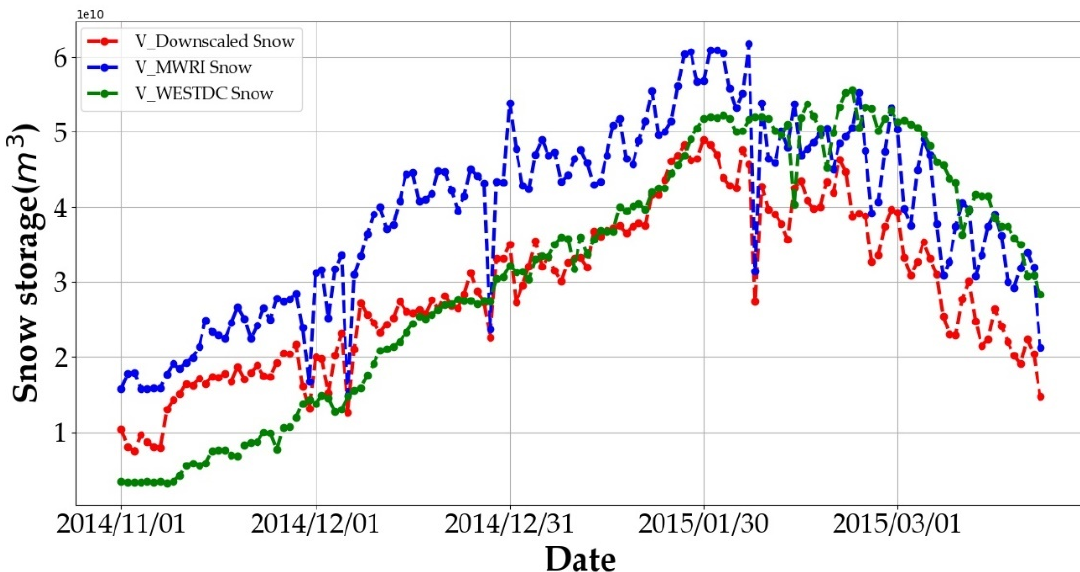
Figure 9. Snow storage generated from three snow depth datasets.